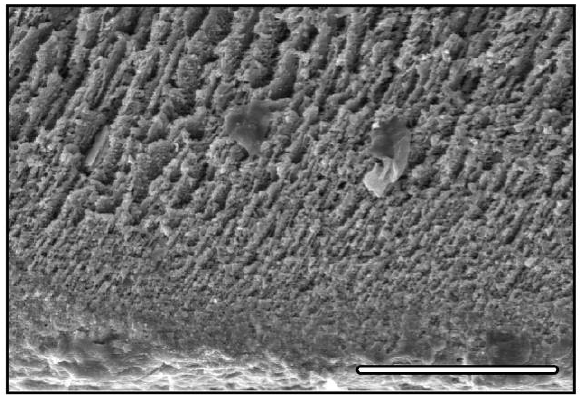
Figure 4. Initial gradient. Cross-section parallel to the solidification direction. The displacement of the solidification interface occurred from bottom to top. Scale bar 100 μ